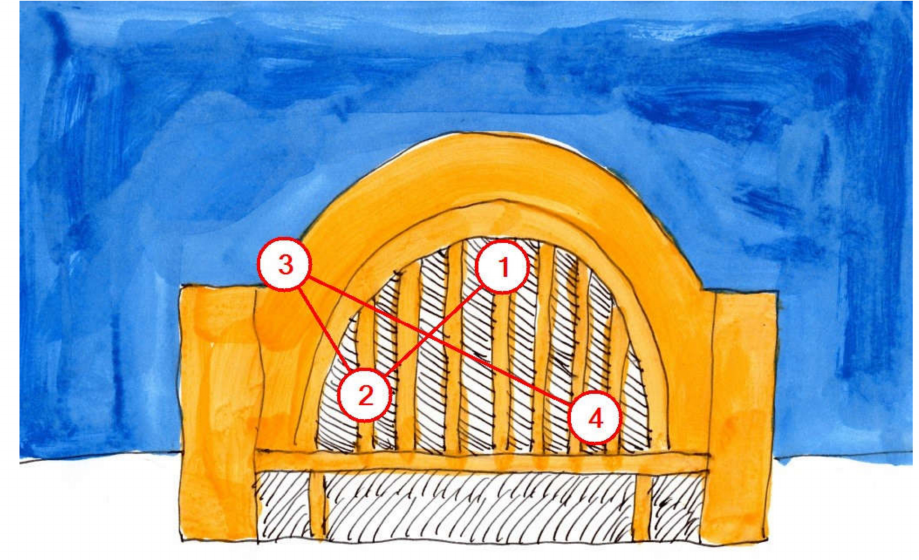
Figure 3. Scanning sequence for Art Deco building.